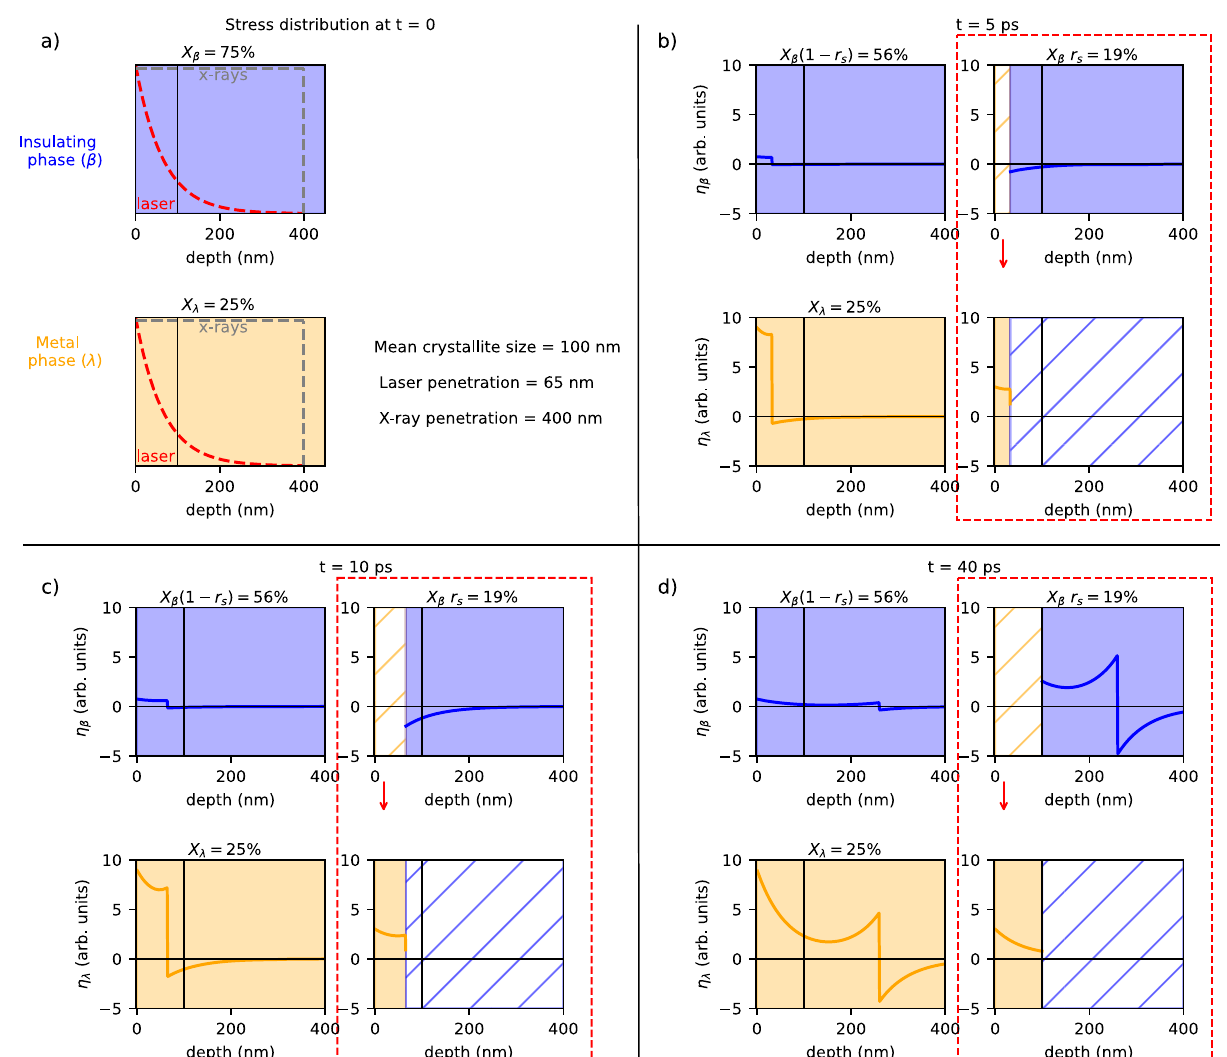
Fig. 5 Strain wave model with phase transition. The spatial dependence of the elastic strain at different times (tagged top of each panel), for β -phase crystalites (in blue, initial fraction X β = 75%) remaining in the initial phase (56%, left side on each panel) and transitioning to λ (19%, right side on each panel), λ -phase crystallites (in orange) remaining in the initial phase (initial fraction X λ = 25%, left side on each panel) and newly formed from β (19% with transformation rate r s = 0.26, right side on each panel). To distinguish the strained-transitioning crystalites from those strained-non transitioning, the former situation is contoured on each panel with a red dashed line and red arrow points to the transition direction. The solid vertical line at z = 100 nm on all panels delimits the phase-transition zone. Semi-in fi nite 1D medium approximates the real sample and the experimental conditions. a Initial photo- induced stress following the laser absorption pro fi le (in red). X-ray probe depth is indicated in gray (details given in Fig. S9). The inset shows the most important values in the experiment. b – d Strain pro fi le η ( z , t ) as calculated according to the model described in the main text. For transitioning crystallites (contoured dashed red) the strain due to the transition is calculated separately for the λ - and β